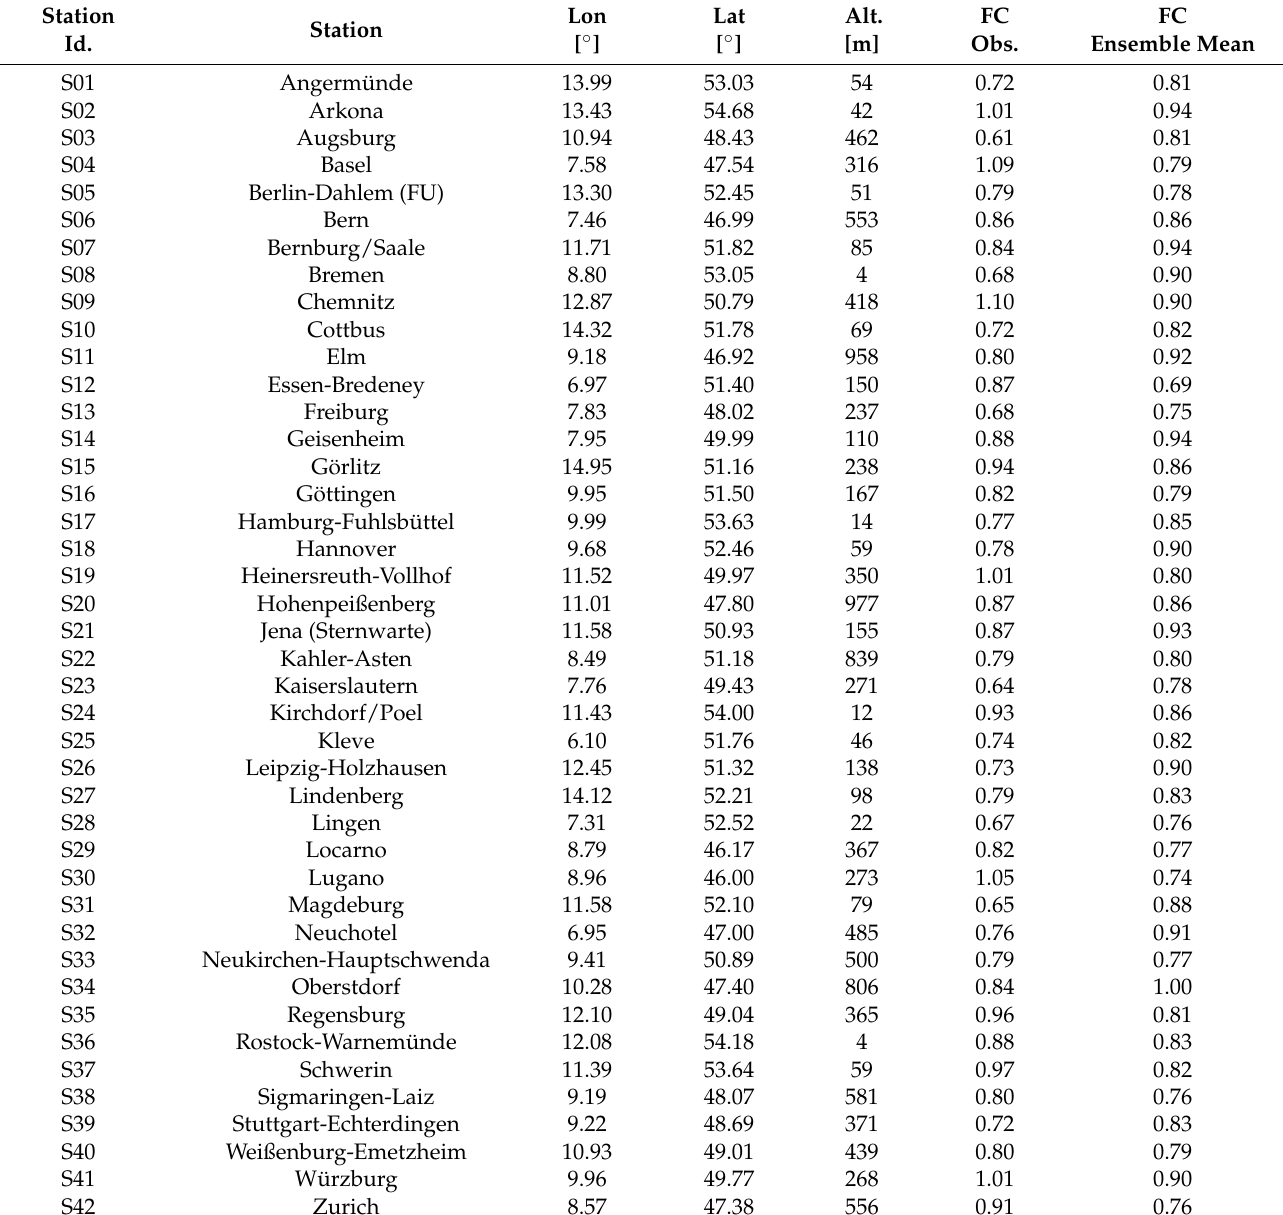
Table 3. Comparison of FC of q k in the time window 1981–2020 with respect to 1951–1990 obtained from the RCMs ensemble and the observations.